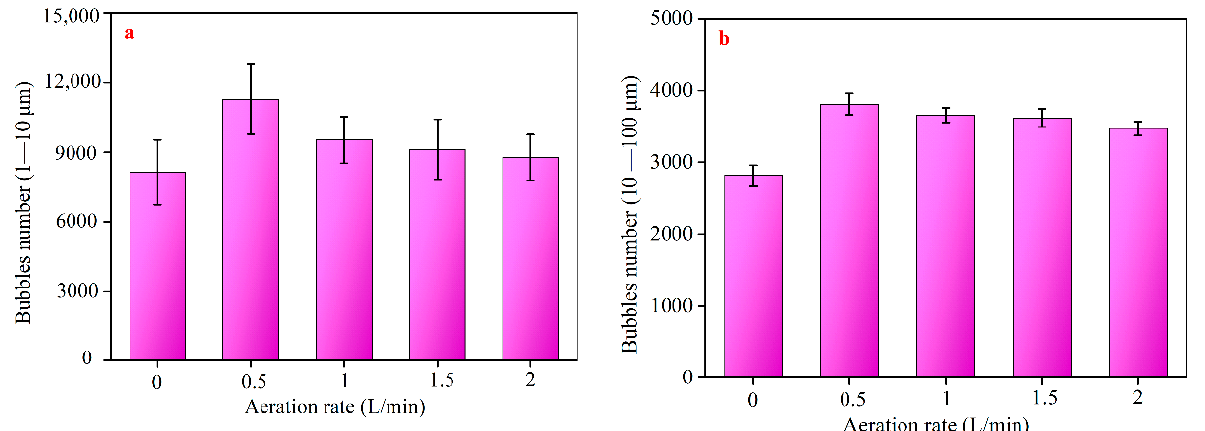
Figure 7. Number of micro-bubbles prepared at different aeration rates categorized as ( a ) 1–10 µ m and ( b ) 10–100 µ m when the preparation time equaled 2 min.